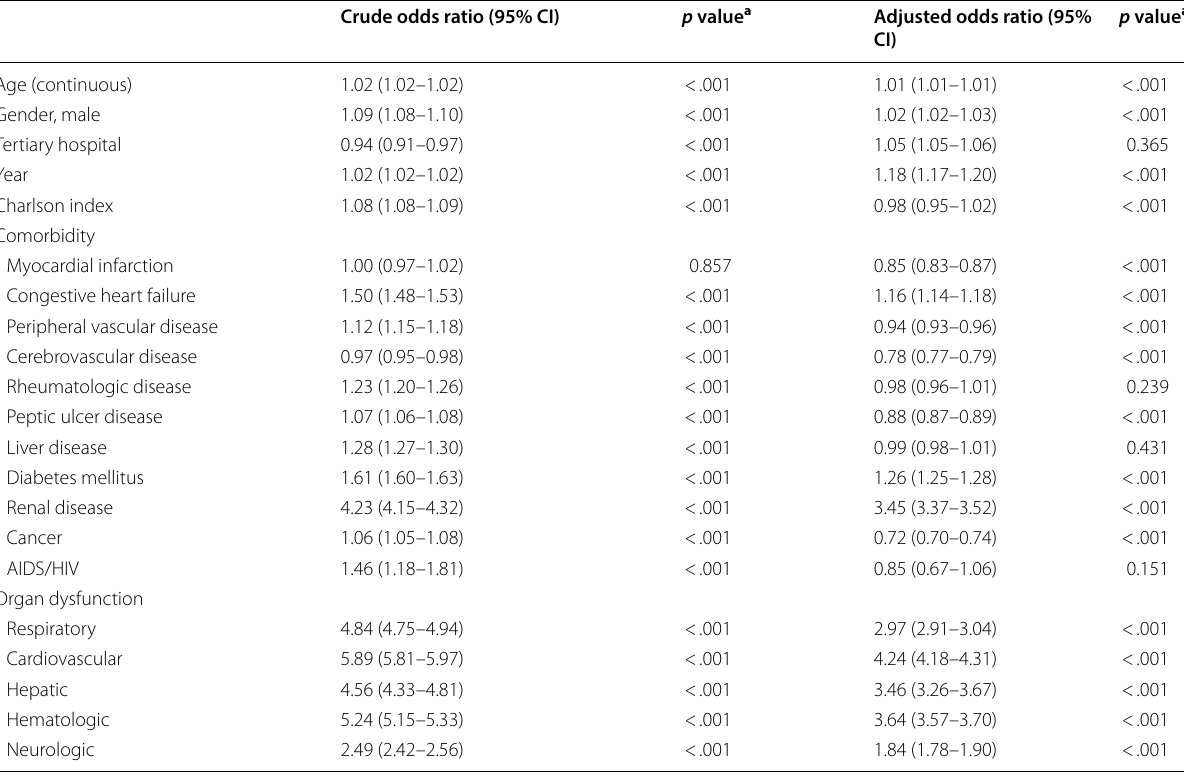
Adjusted for age, gender, tertiary hospital, year, Charlson index, myocardial infarction, congestive heart failure, cerebrovascular disease, rheumatologic disease, peptic ulcer disease, liver disease, diabetes, renal disease, cancer, AIDS/HIV, and organ dysfunction (respiratory, cardiovascular, hepatic, hematologic, neurologic) AIDS acquired immune deficiency syndrome, CI confidence interval, HIV human immunodeficiency virus a Mixed effects logistic regression model